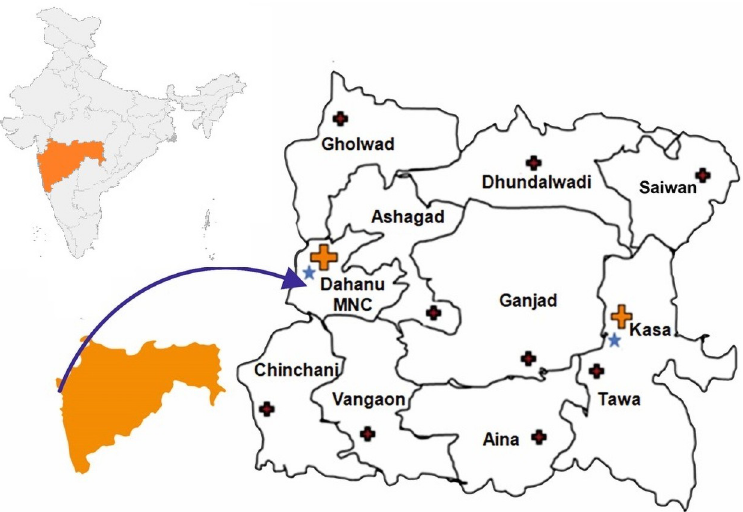
Fig 1. The geographical location of Dahanu block, Palghar District, Maharashtra, India. Map not to scale.